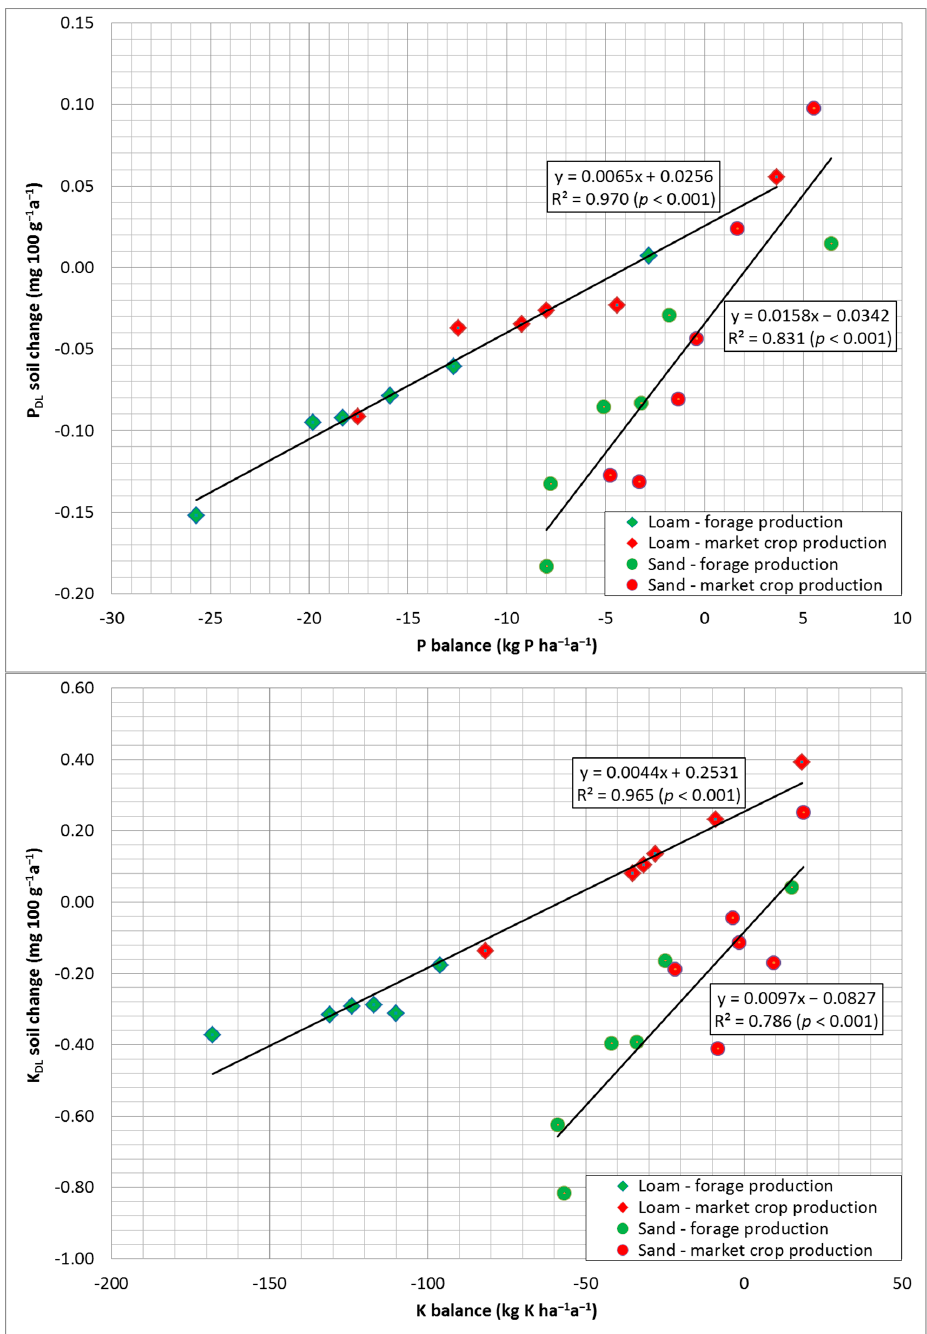
Figure 4. Relationship between increasing P and K balances and the annual change in P DL ( above ) and K DL ( below ) concentrations of loamy and sandy soils in organic farming systems with 33% forage legumes in the crop